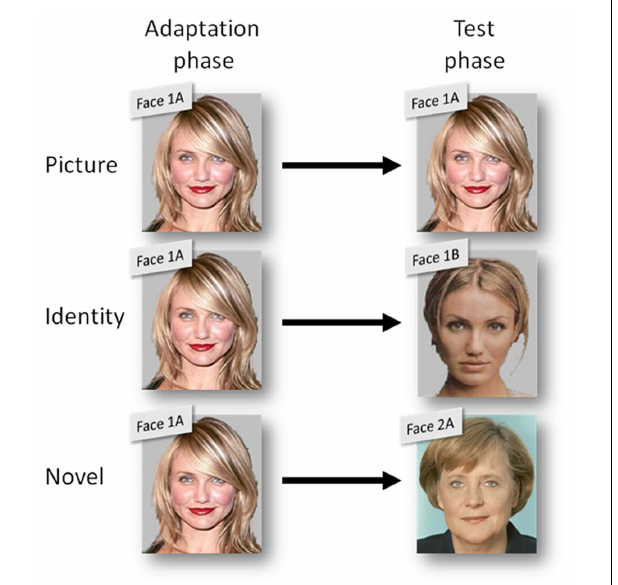
FIGURE 2 | Illustration of the three stimulus compatibility conditions (between adaptation and test phase): picture with same pictures of the same person (e.g., face picture 1A and 1A), identity with different pictures of the same person (e.g., 1A and 1B), and novel with pictures of different persons (e.g., 1A and